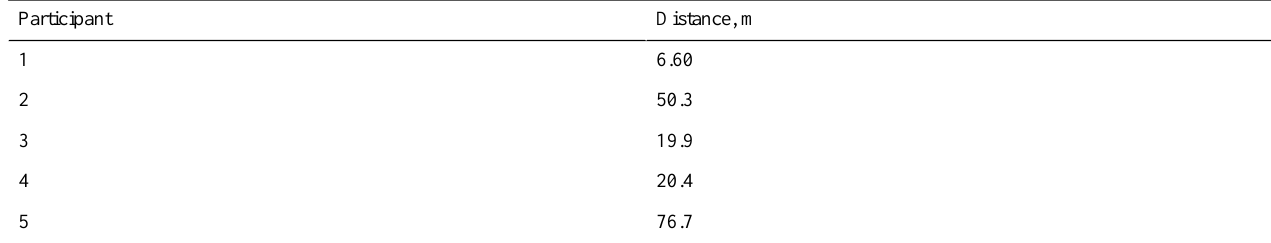
Table 5. Distances between the actual home locations and extracted home locations.